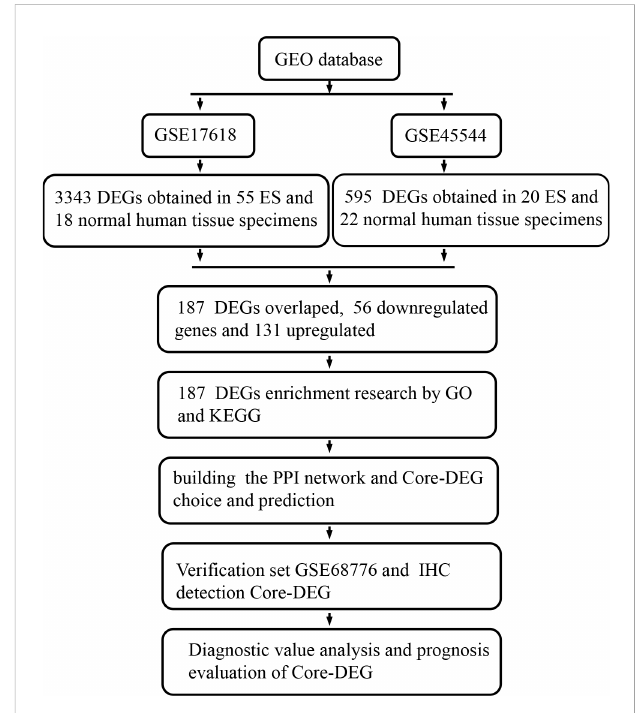
FIGURE 1 This study ’ s fl ow diagram. GEO, Gene Expression Omnibus database; ES, Ewing ’ s sarcoma; DEGs, Differentially expressed genes; GO, Gene Ontology; KEGG, Kyoto Encyclopedia of Genes and Genomes; PPI, protein-protein interaction; IHC,